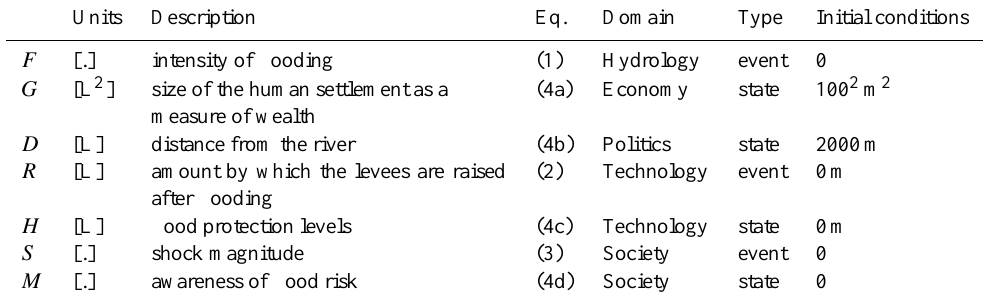
Table A1. Variables of the dynamic system and their initial conditions in the examples of Sect. 3 (Figs. 4 and 5). Units